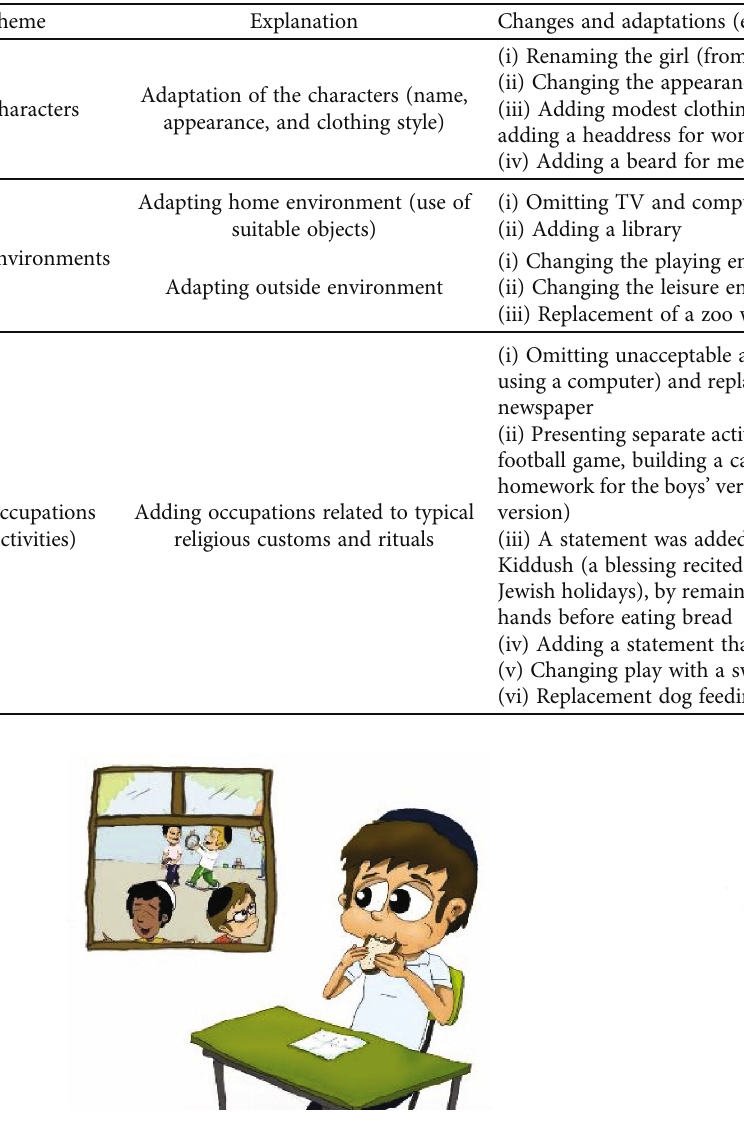
Table 1: Summary of themes, explanations, and examples as reported by participants in stages I and II of the study.